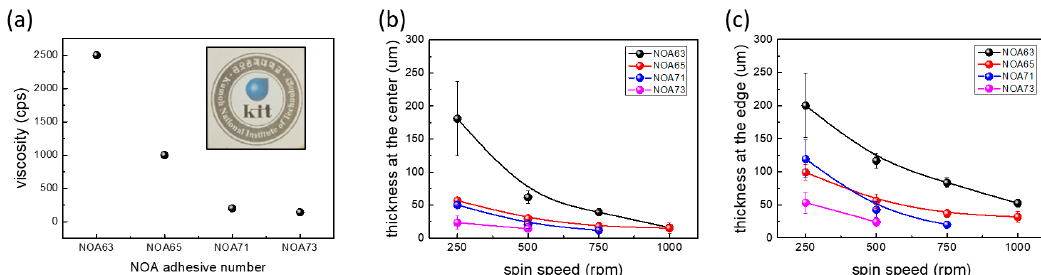
Figure 4. ( a ) Viscosity of the Norland optical adhesive (NOA) series solutions and ( b–c ) electrode thickness at the ( b ) center and ( c ) edge as a function of the spin-coating speed for different viscosities. In (a), the inset is a photograph of a silver-nanowire-embedded electrode in NOA.